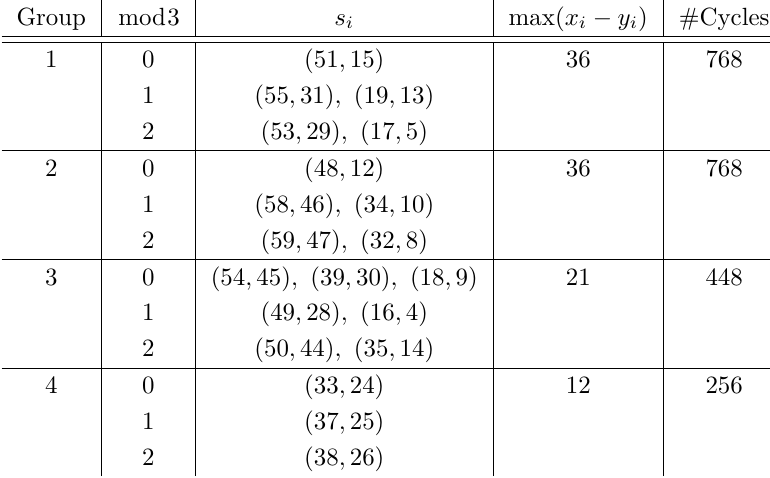
Table 4: Concurrent execution of the s i ’s in the PRESENT permutation